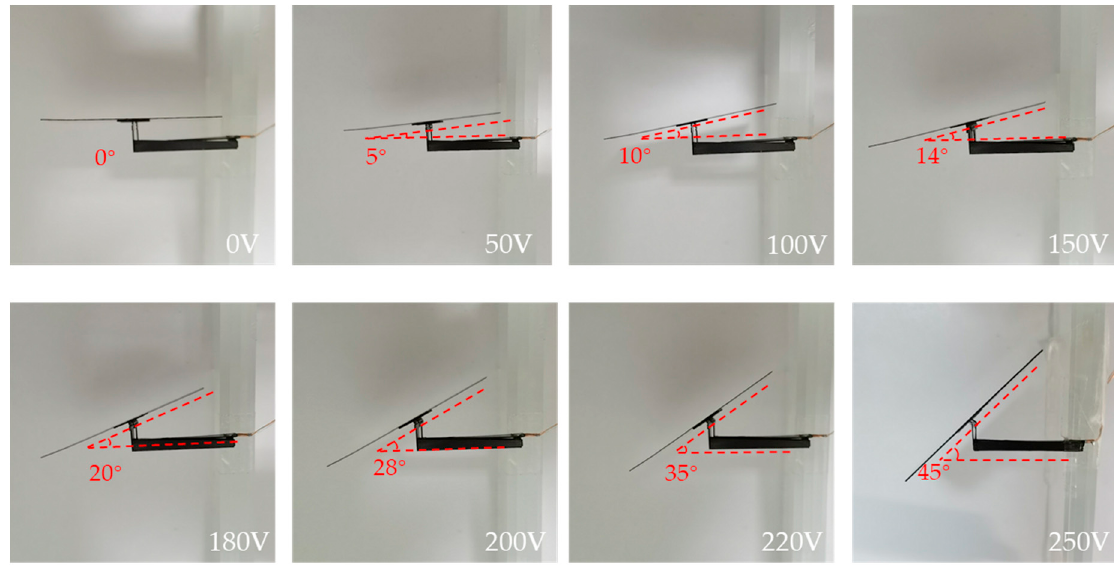
Figure 7. ( a ) Experimental product of miniature piezoelectric drive squama deformation mechanics; ( b ) squama.